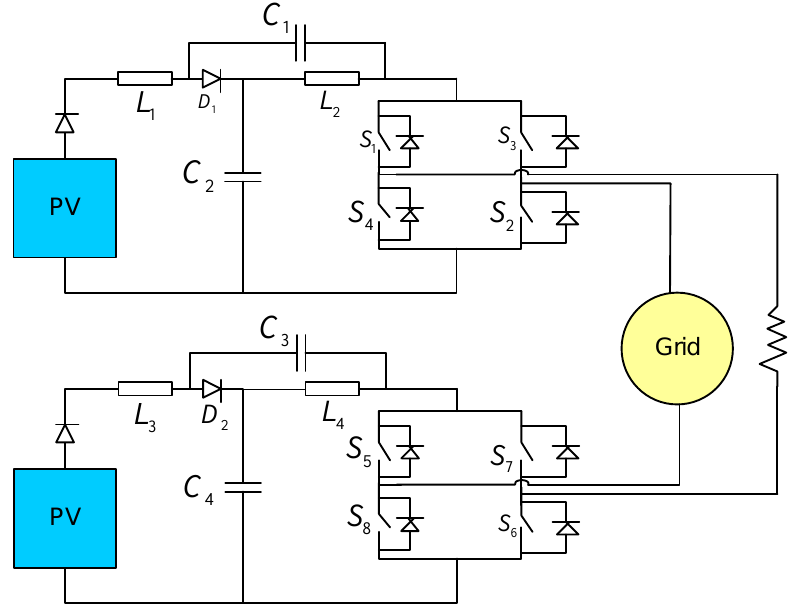
Figure 19. Five level qZSMLI with PV source .